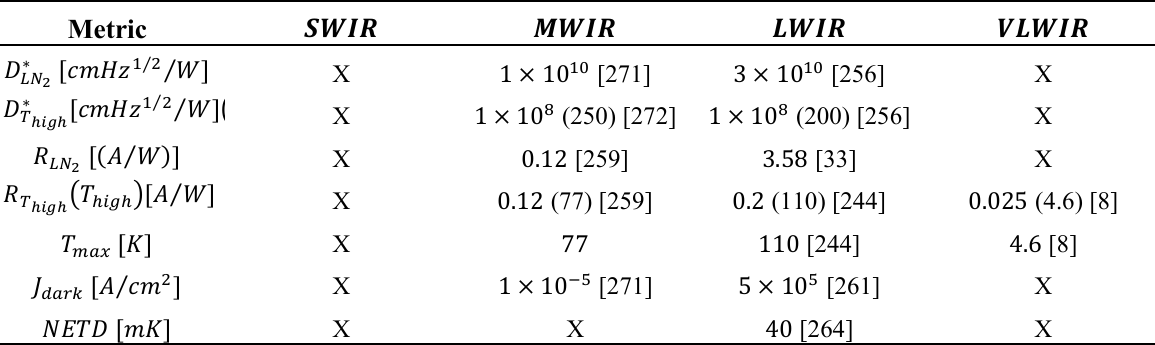
Table 5. Highest reported performance metrics for DWELL IRPDs across different wavelength regimes.